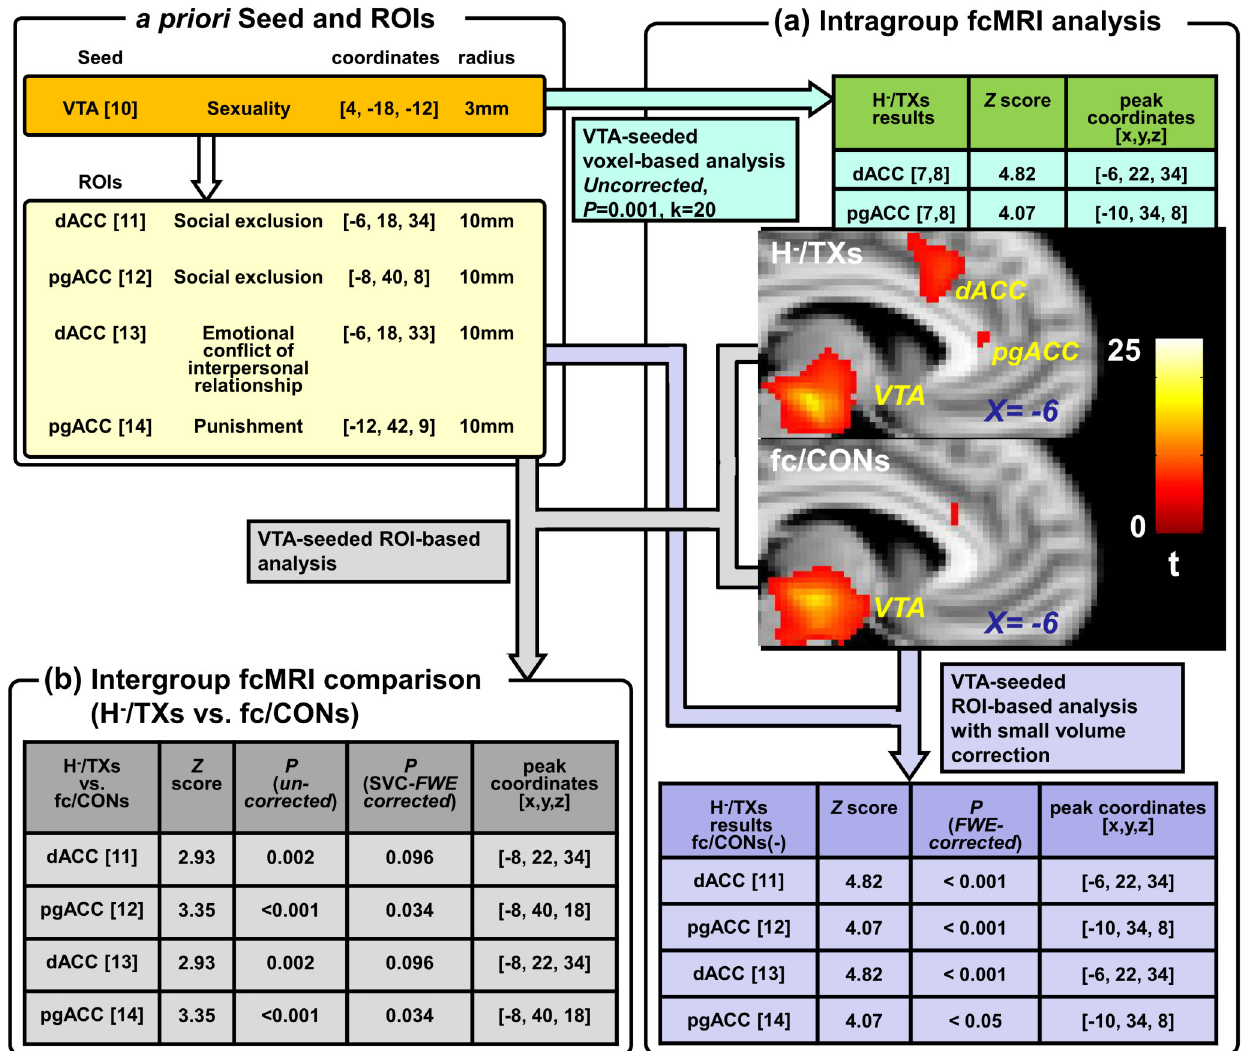
Figure 2. A priori voxel-based and ROI-based correlation analyses. Panel a. Intragroup comparison . Voxel-based correlation analysis was performed by anchoring the VTA as the seed region (defined as a sphere with a 3-mm radius centered at the MNI coordinates [4, 2 18, 2 12]) [11]. The a priori ROIs specifically relate to the processing of social exclusion [13,14], emotional conflict in interpersonal relationships [15] and behavioral adjustments in response to punishment [16]. VTA-seeded ROI (radius =10 mm)-based analysis with a small-volume correction(SVC, controlled for the family-wise error, P=0.05) was performed based on the connectivity map for H 2 /TXs and fc/CONs. Panel b. Intergroup comparison . The same VTA- seeded ROI-based analysis was performed using the contrast map (H 2 /TXs . fc/CONs) with and without a SVC. [X] indicates the cited